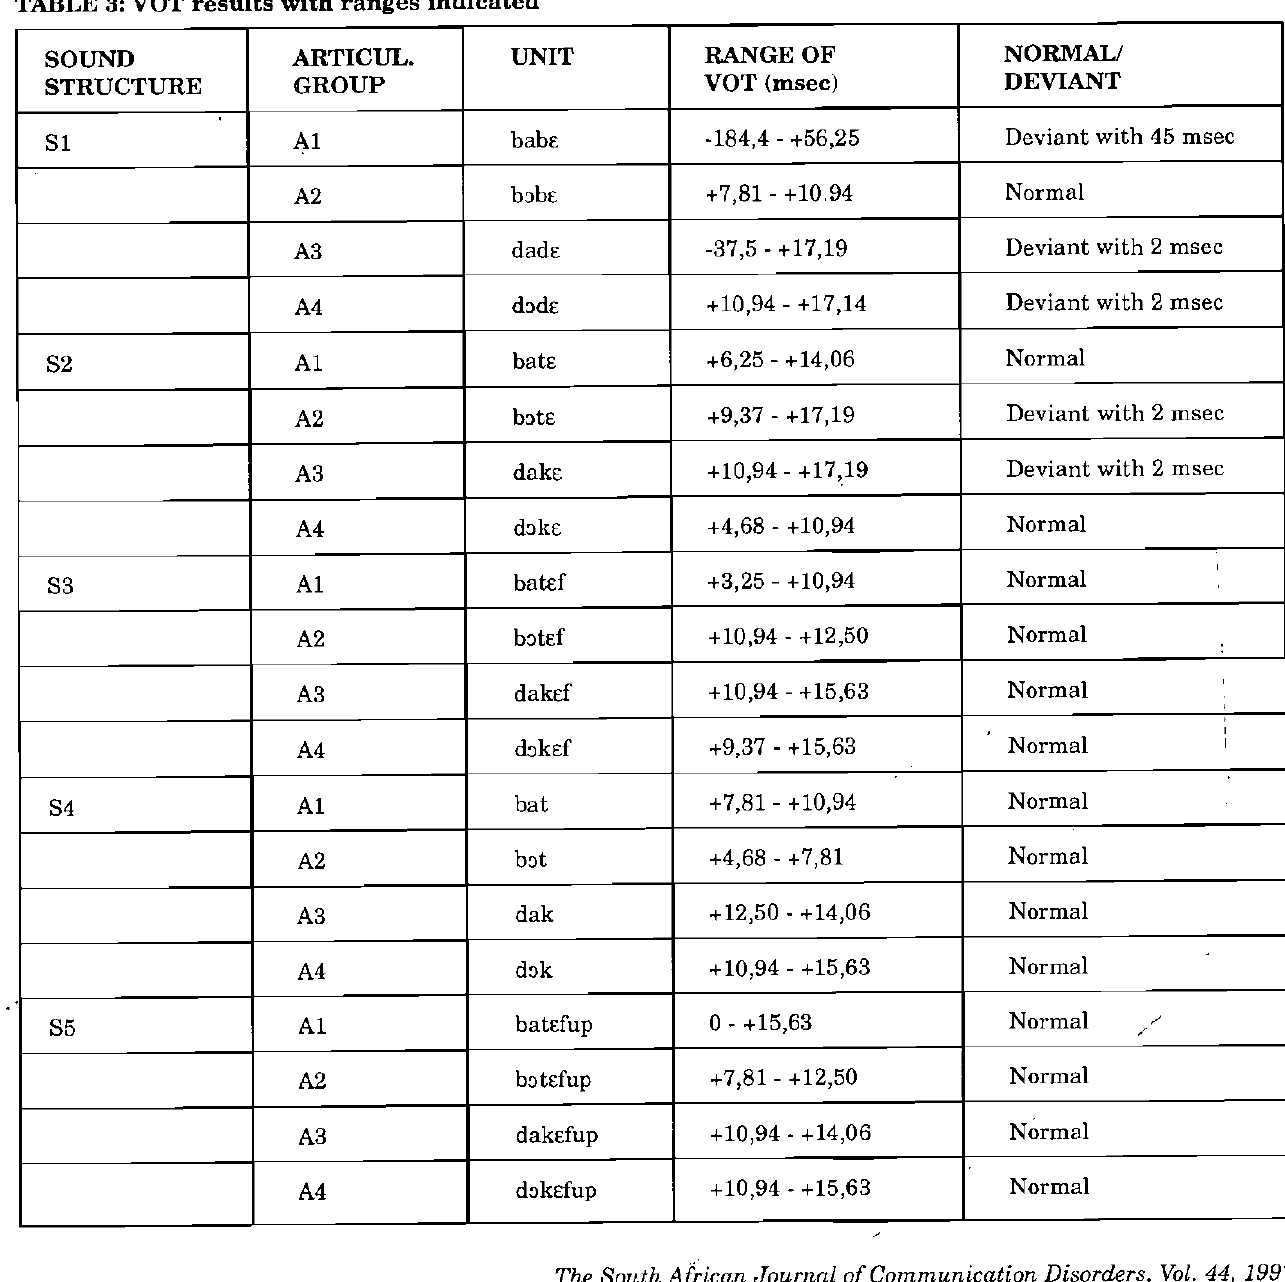
TABLE 3: VOT results with ranges indicated SOUND STRUCTURE